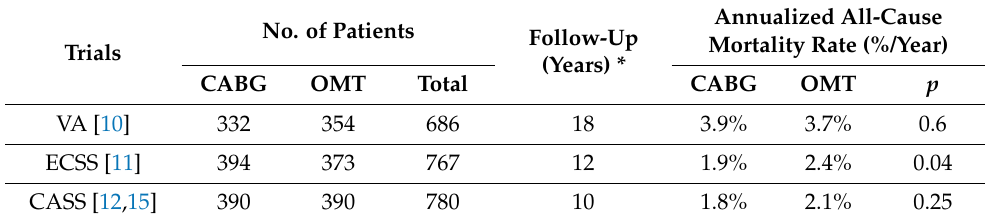
Table 1. All-cause mortality in the main trials comparing medical treatment plus coronary artery bypass grafting (CABG) surgery vs. medical treatment alone in patients with chronic coronary syndrome.